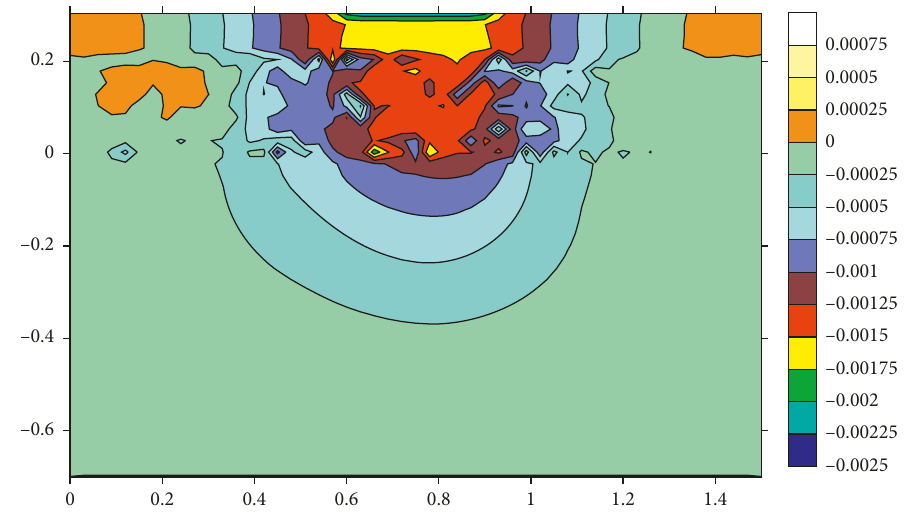
Figure 12: Vertical displacement contour of the